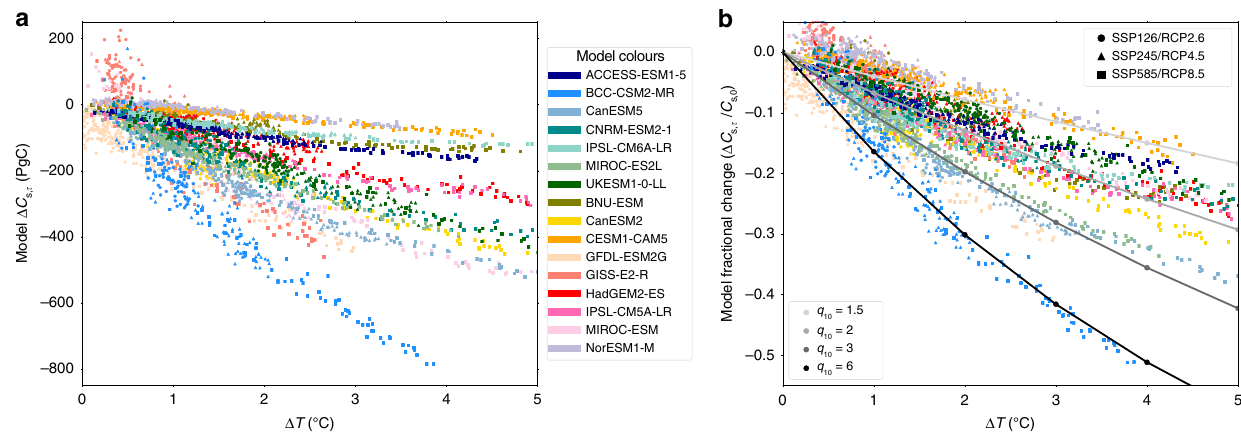
Fig. 1 Uncertainty in future changes in soil carbon due to reduction in turnover time. Δ C s, τ vs. Δ T plot diagnosed from sixteen Earth System Models (seven CMIP6 ESMs and nine CMIP5 ESMs), for three different future scenarios: SSP126, SSP245, SSP585, or RCP2.6, RCP4.5, RCP8.5, respectively. a The change in soil carbon due to the change in soil carbon turnover time against change in global mean temperatures; b The fractional change in soil carbon due to the change in soil carbon turnover time against change in global mean temperatures, and compared to different effective q 10 sensitivities.